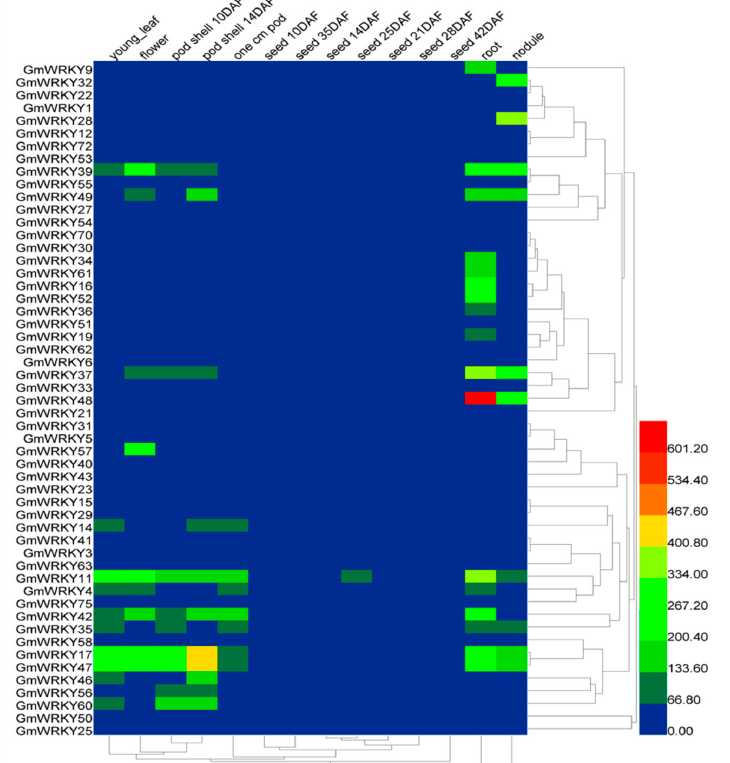
Figure 1. Expression pattern of fifty-three GmWRKYs in six different tissues (young leaf, flower, pod shell, seed, root and nodule). The fifty-three GmWRKYs were selected from drought treatment RNA-Seq data based on the rule that log 2 (GH_treat/CK1_treat) >1. The tissue expression is from SoyDB (http://soykb.org/). The color legend refers to the different expression level under normal condition. “DAF” in the tissue label indicates days after flowering.